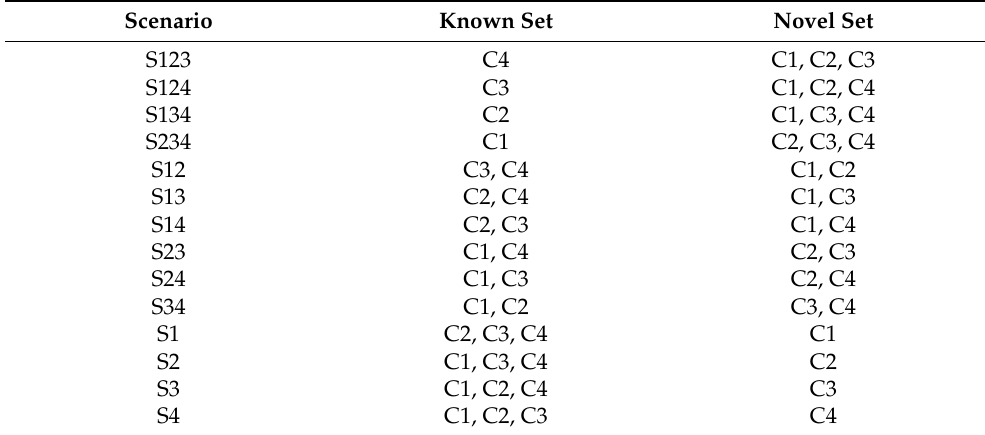
Table 5. Scenarios used for the evaluation of the novelty detection task with anomalies. Scenario